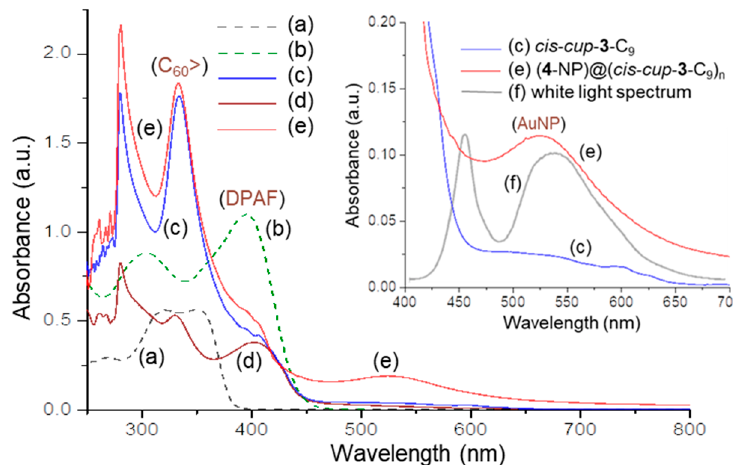
Figure 4. UV ‐ vis spectra of (a) cis ‐ cup ‐ tris(DPAF ‐ C 9 ) ( cis ‐ cup ‐ 2 ‐ C 9 ), (b) cis ‐ cup ‐ tris(BrDPAF ‐ C 9 ), (c) cis ‐ cup ‐ tris[C 60 (>DPAF ‐ C 9 )] ( cis ‐ cup ‐ 3 ‐ C 9 ), (d) C 60 (>DPAF ‐ C 9 ) ( 1 ‐ C 9 ), (e) ( 4 ‐ NP)@( cis ‐ cup ‐ 3 ‐ C 9 ) n ( 5 ‐ NPs), and (f) white light emission spectrum, where (a) and (b) were taken in EtOAc and (c), (d), and (e) were taken in toluene. The concentration of all samples is 1.0 × 10 –5 M.